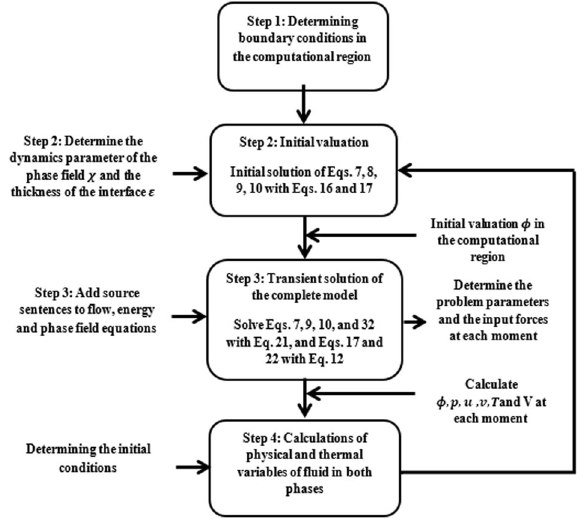
Fig. 8 Problem-solving fl owchart. The fl owchart provides different steps including determination of boundary conditions, initial valuation, transient solution of the complete model, and calculation of fl uid properties used in the developed